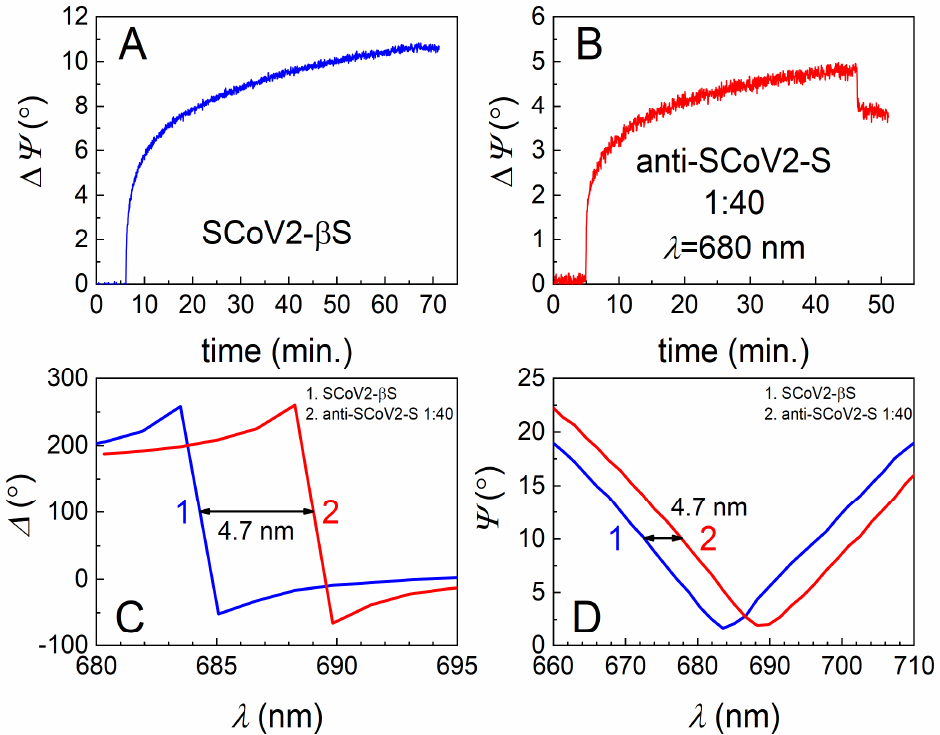
Figure 4. Time-resolved TIRE kinetics and ellipsometric parameters of SCoV2- β S immobilization and interaction with specific polyclonal antibodies. ( A ) Kinetics of covalent SCoV2 β -S immobilization on 11-MUA SAM modified gold-coated SPR sensor disc; ( B ) kinetics of polyclonal antibody interaction with covalently immobilized SCoV2- β S at 1:40 dilution of serum; ( C ) ∆ and ( D ) Ψ spectral shift after the formation of immune complexes using the same dilutions of polyclonal antibod- ies.